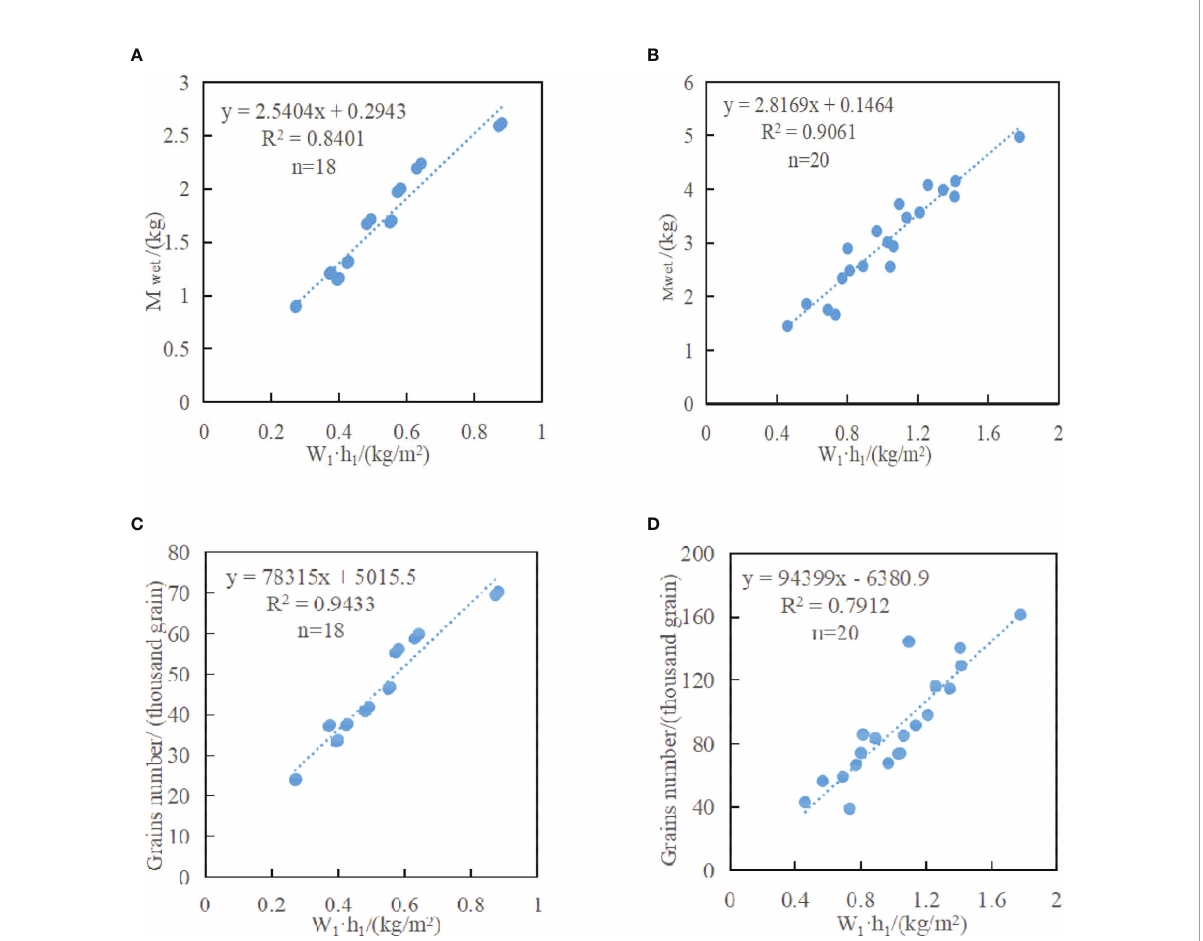
FIGURE 5 Inversion model of wet weight of ear and grain number per ear. (A) is the scatter diagram between (W 1 ·h 1 ) B and wet weight of rice ear scattering model M wetB . (B) is the scatter diagram between (W 1 ·h 1 ) CDE and wet weight of rice ear scattering model M wetCDE . (C) is the scatter diagram between (W 1 ·h 1 ) B and grain number per rice ear scattering model N B . (D) is the scatter diagram between (W 1 ·h 1 ) CDE and grain number per rice ear scattering model N CDE